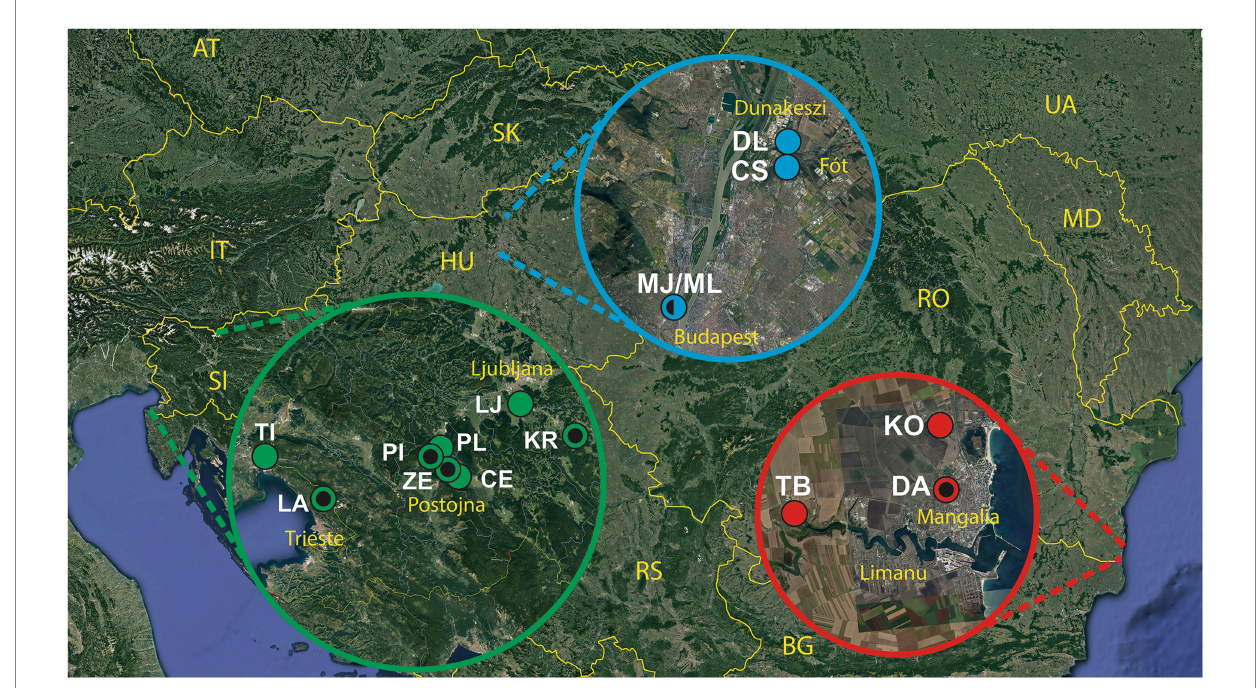
FIGURE 1 Map showing the geographical locations of sample sites. Black dots in the middle of colored circles denotes cave populations. For the population abbreviations, see Table 1. Note that MJ (cave) and ML (surface) populations are very close to each other, hence, they are represented by the same circle.